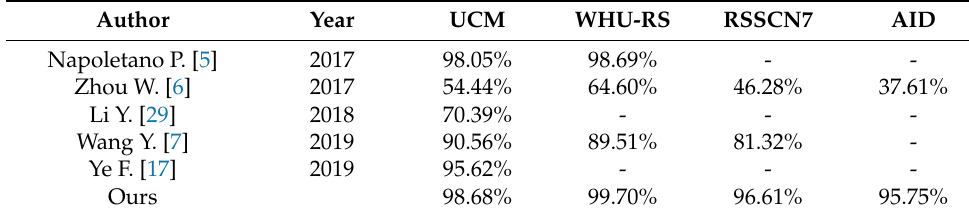
Table 6. Performance comparison with existing